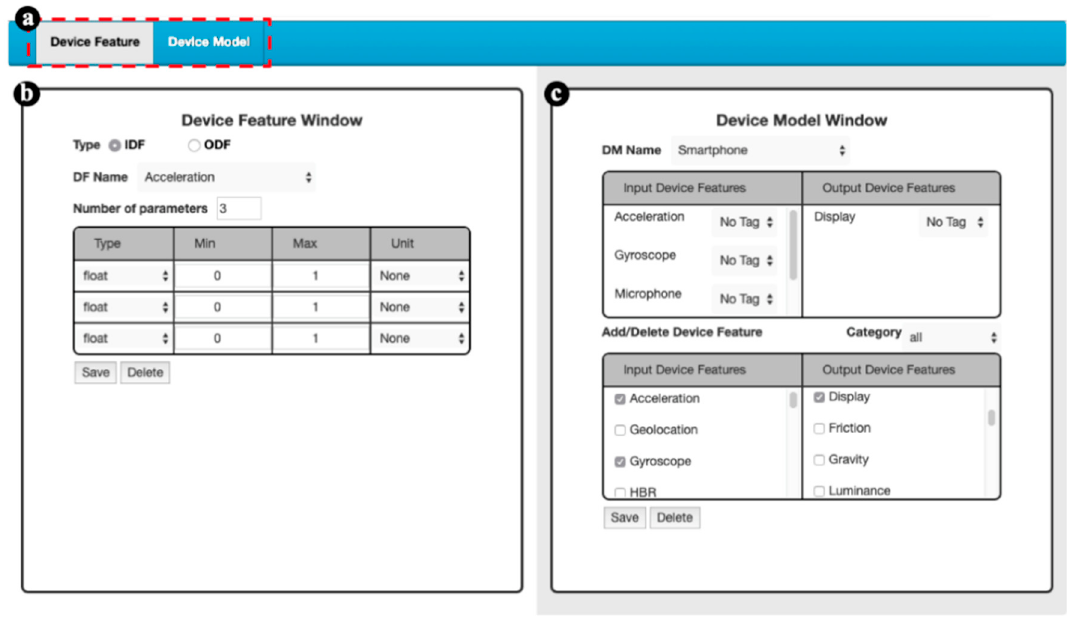
Figure A1. Device Feature and Model Management page.